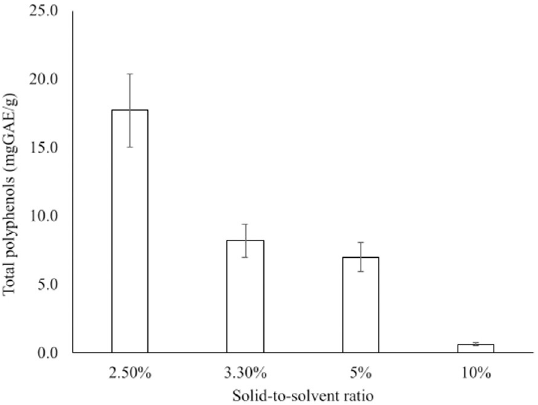
Fig 3. Effect of solid-to-solvent ratio on the extraction of total polyphenols from fruits of A . esculentus .